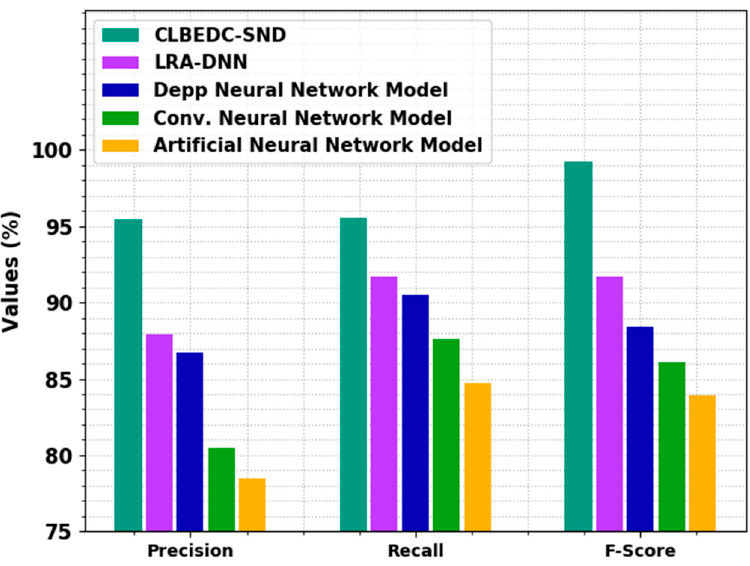
Figure 11. Comparative analysis of CLBEDC-SND technique with existing algorithms.